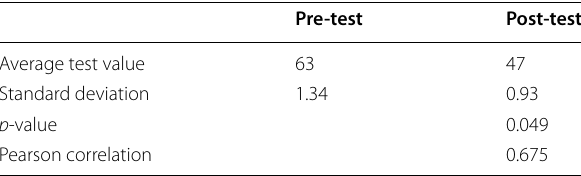
Thinking Test (CCTT) for pre- and